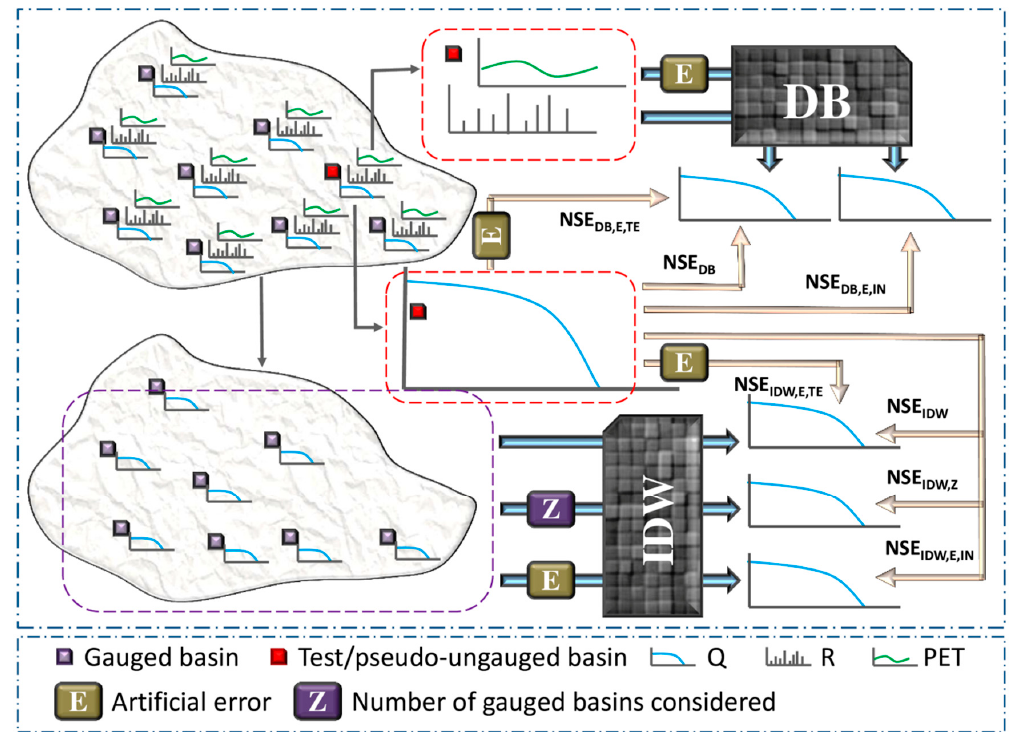
Figure 2. Schematic diagram depicting the model evaluation exercise performed in this study. Let us consider a hypothetical case of a region with data from 𝐽 basins to evaluate the two FDC models (DB and IDW). Each basin has observed discharge time series from which flow duration curve (FDC) is 𝑖 th basin) as the test/pseudo-ungauged basin whose FDC is now the ‘test data’ (see the legend). Its